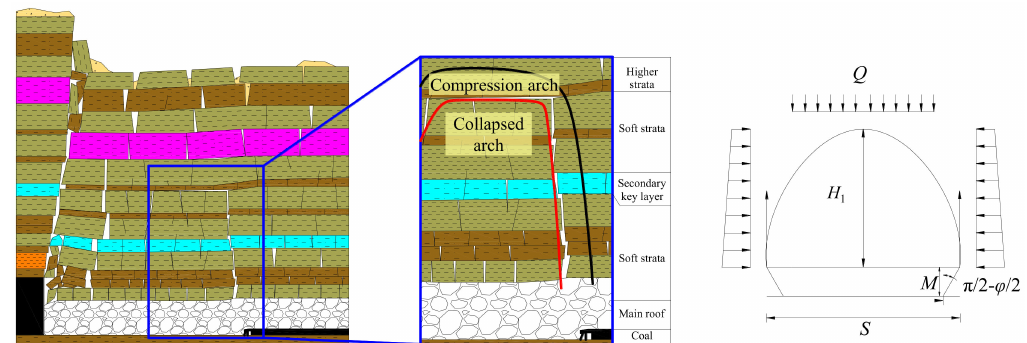
Figure 12. The shields and surrounding rock relationship for a overburden arch structure ( H 1 —height of the collapsed arch structure; ϕ —seam breakage angle; S —maximum width of the compression arch; Q —vertical stress